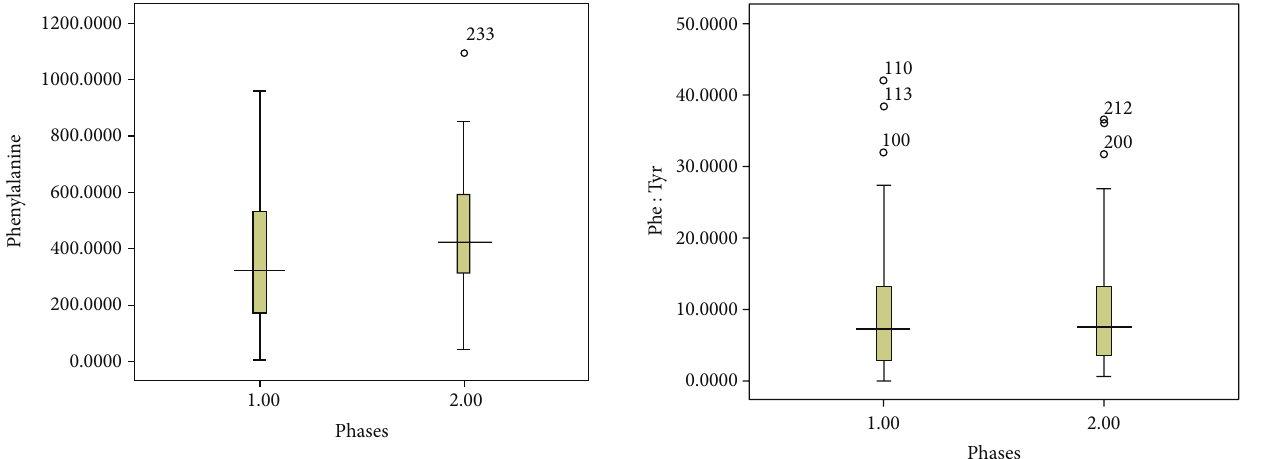
Figure 1: The level of Phe in the phases of the study in ten patients (70 samples in phase I and 66 samples in phase II). Figure 2: Level of Phe/Tyr ratio in the phases of the study in ten patients (70 samples in phase I and 66 samples in phase II).